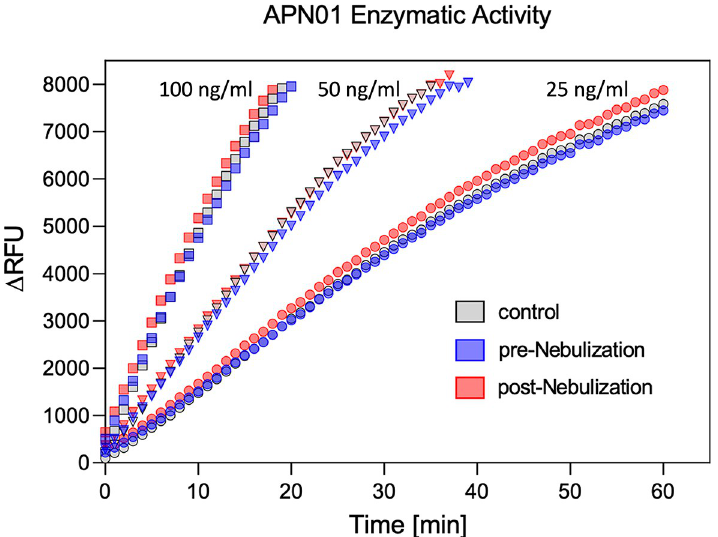
Fig 4. APN01 enzymatic activity is not altered by nebulization. Three samples were tested as defined in the legend to Fig 3. Samples were diluted to APN01 concentrations of 25 ng/ml, 50 ng/ml, and 100 ng/ml and assayed for enzymatic function by cleavage of quenched fluorogenic MAPL-DNP substrate and subsequent measurement of fluorescence activity. Data are plotted as Δ RFU (change in relative fluorescence units) vs. time (min). One representative experiment out of 4 biological replicates is